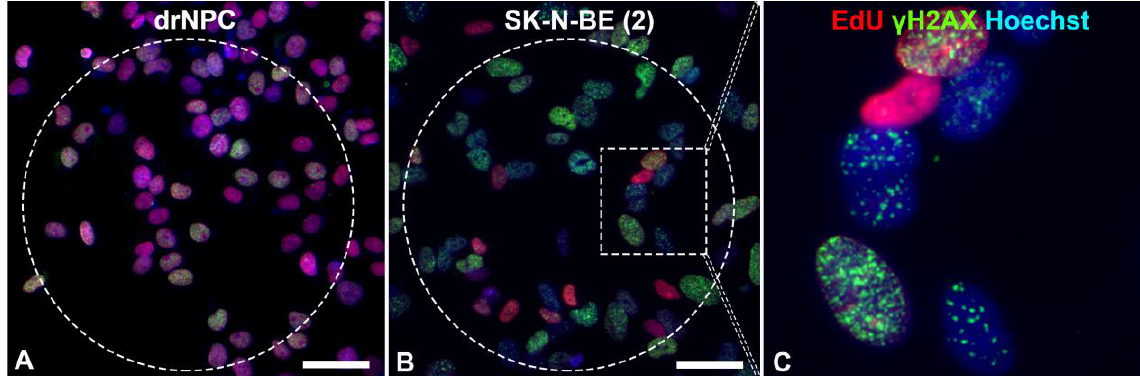
Figure 3. Immunofluorescent analysis of the γH2AX foci in: ( A ) drNPCs and ( B , C ) SK-N-BE (2) cells. The THz-irradiated region is marked with a dashed line. The γ H2AX foci (green) are found both in cells in the synthesis phase of the cell cycle (EdU, red) and those in the post-synthesis phase. The cell nuclei are stained with Hoechst (blue) in all the images. Circle denotes the area of THz exposure. Square denotes the magnified region shown in section ( C ). Scale bar 100 µm.